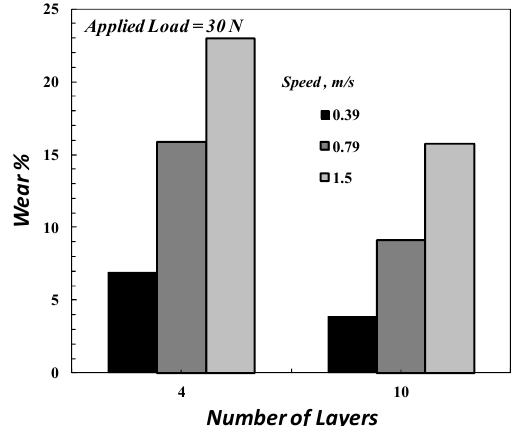
Figure 9. Wear rate as a function of applied load for different FGM specimens.